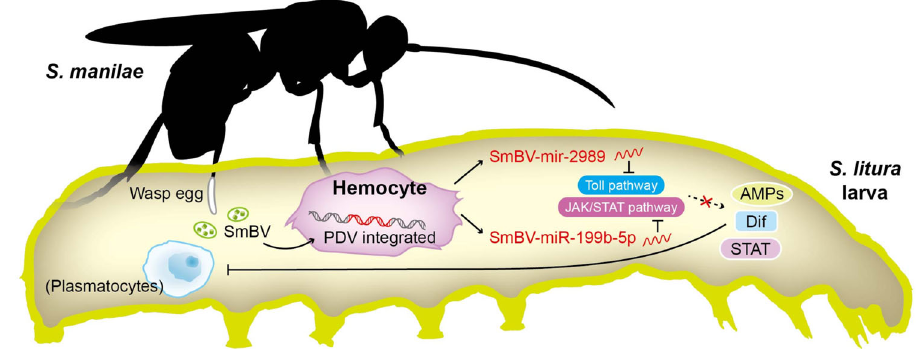
Fig. 6 SmBV-encoded microRNAs as regulators in host immune responses. Upon the parasitism of wasp S. manilae to its host S. litura , the symbiotic SmBV integrates viral DNA into the host genome in hemocytes, and subsequently expresses miR-199b-5p and miR-2989 that inhibit signal transductions in JAK/STAT and Toll pathways, respectively. These suppressions indirectly block the function of STAT and Dif, alongside AMP synthesis inhibition, resulting in decreased immunity in plasmatocytes and increased pupation rate of the wasp larvae in the